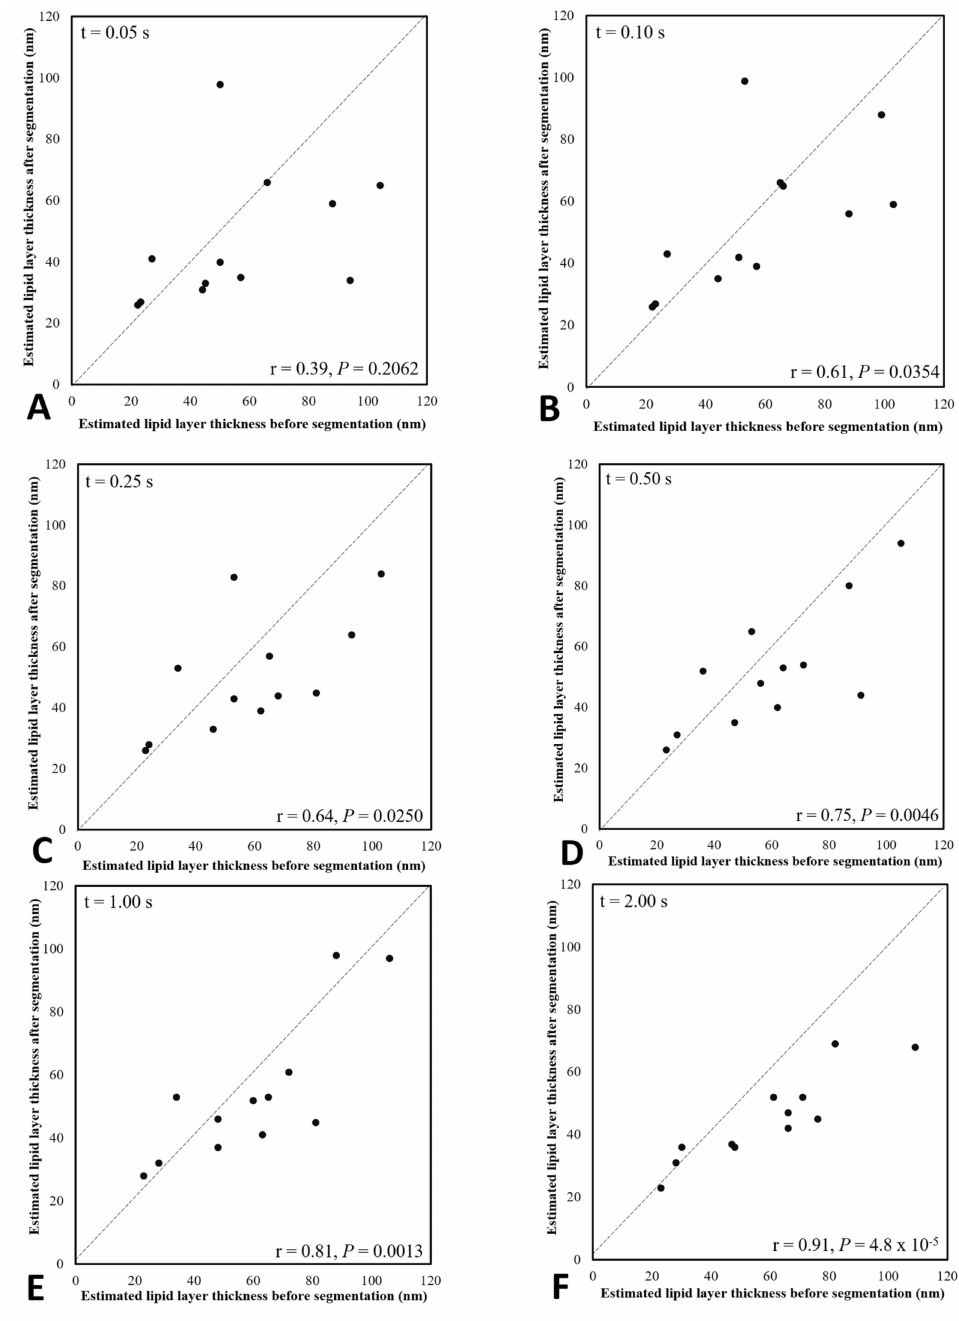
Figure 5. The correlation of the estimated lipid layer thickness between pre- and post-segmentation at di ff erent time points for the right eyes of the 12 subjects. ( A ) at 0.05 s; ( B ) at 0.1 s; ( C ) at 0.25 s; ( D ) at 0.5 s; ( E ) at 1.0 s; ( F ) at 2.0